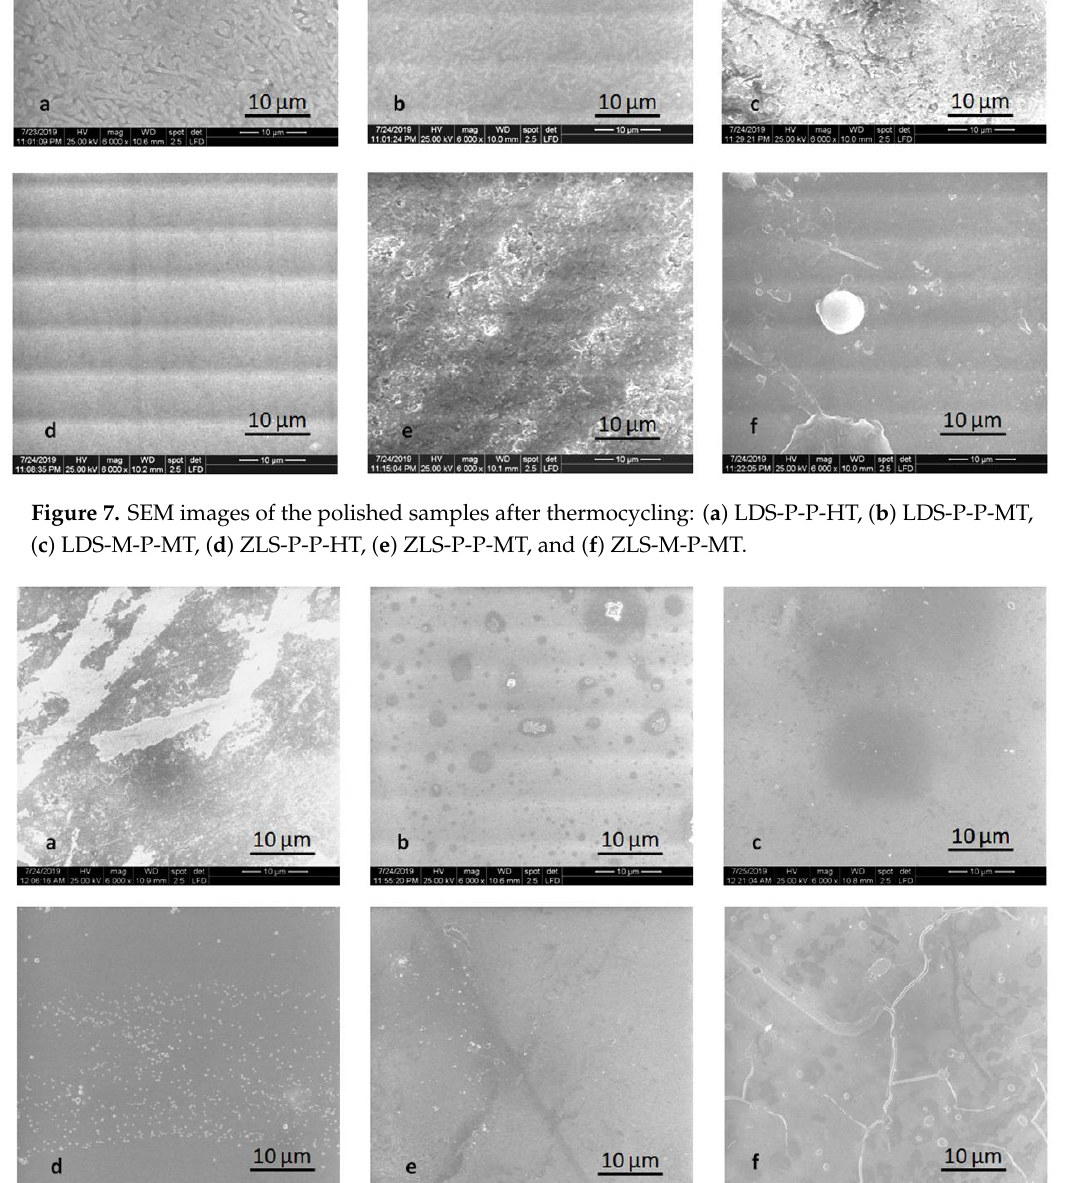
Figure 8. SEM images of the glazed samples after thermocycling: ( a ) LDS-P-P-HT, ( b ) LDS-P-P-MT, ( c ) LDS-M-P-MT, ( d ) ZLS-P-P-HT, ( e ) ZLS-P-P-MT, and ( f ) ZLS-M-P-MT.